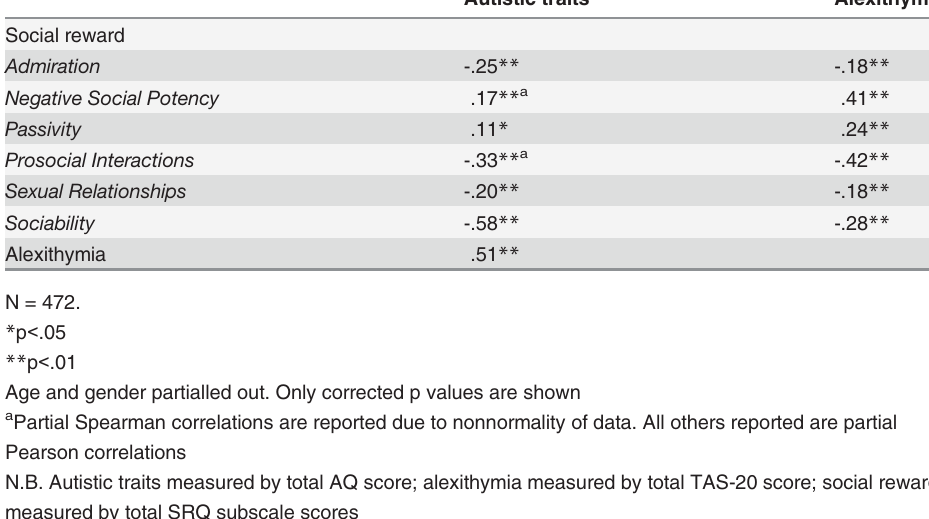
Partial Spearman correlations are reported due to nonnormality of data. All others reported are